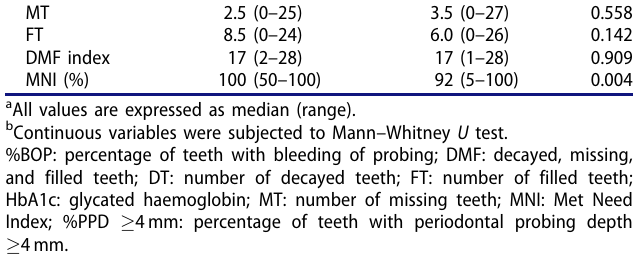
Table 1. Subject characteristics. Characteristics